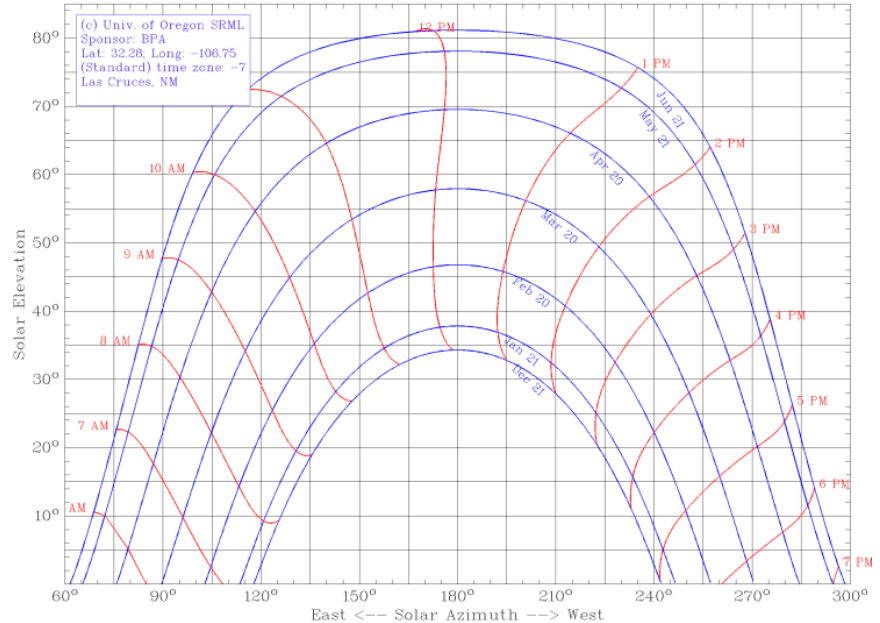
Figure 8. Solar chart for Las Cruces, NM [46].